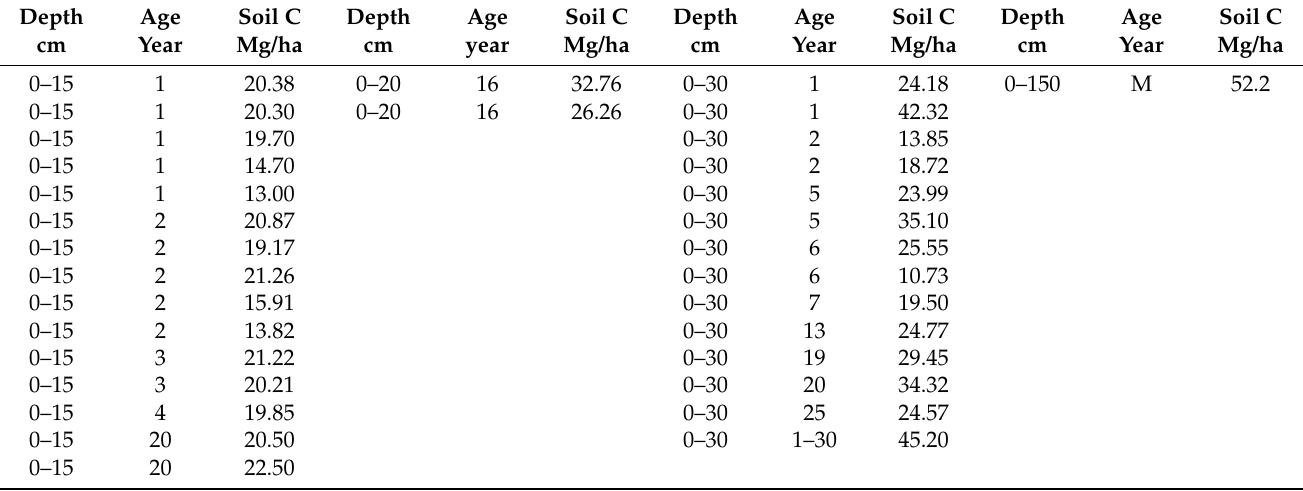
Table 3. Soil organic carbon stocks in re-growth miombo woodlands at various stages of recovery ranging from 1 to 30 years since abandonment